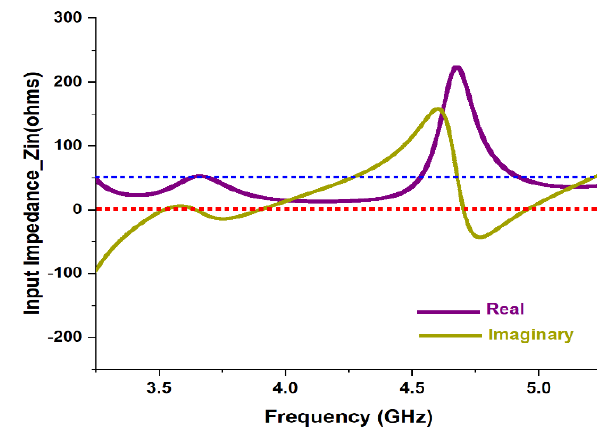
Figure 4. Graph of input impedance vs. frequency.